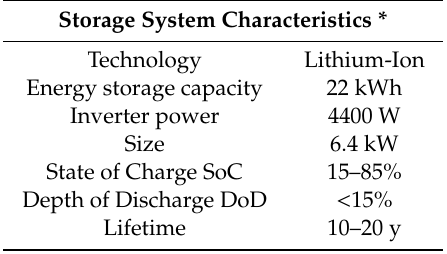
Table 1. Main characteristics of the batteries integrated with the photovoltaics (PV)